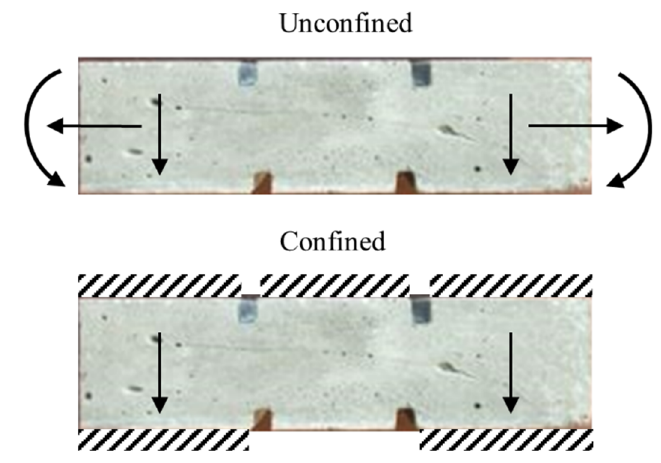
Figure 5. Boundary conditions of the specimen in confined and unconfined shear experiments. The arrows show the possible movement directions, and the cross-hatched areas represent glue.